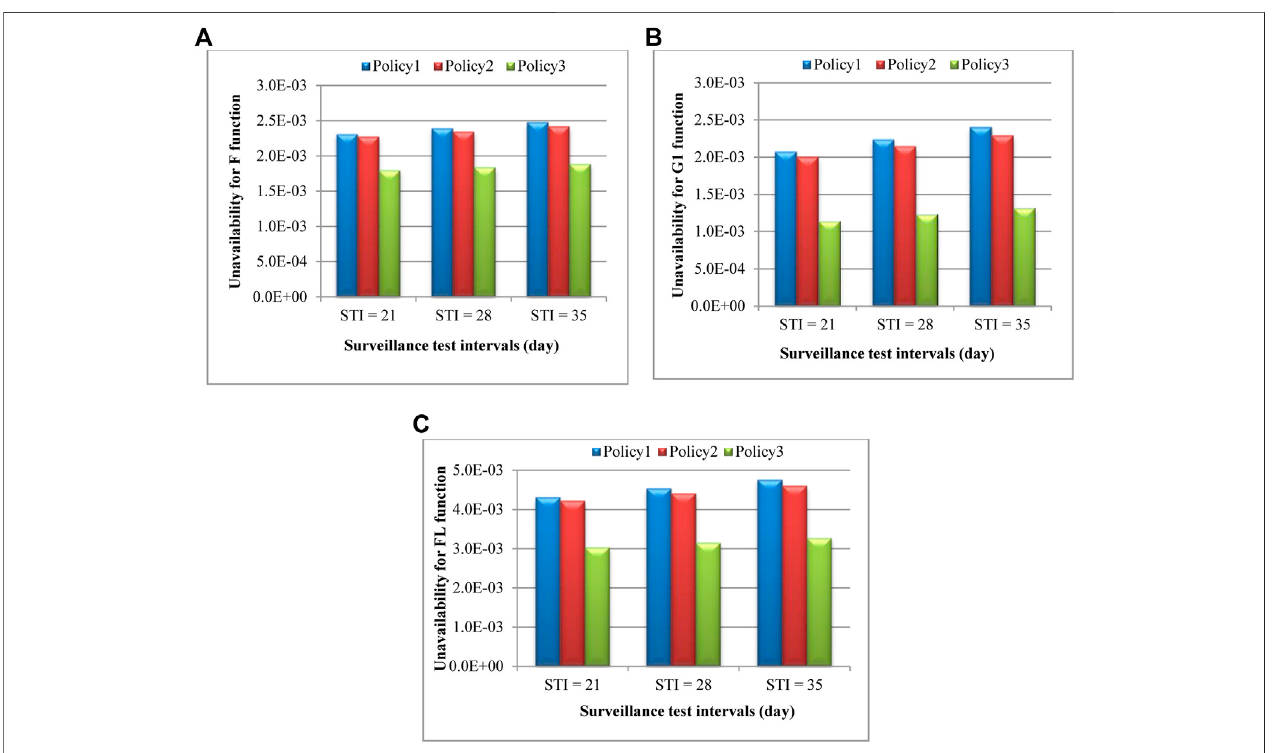
FIGURE 9 | Comparison of unavailability between different STIs and three maintenance policies for functions of ECCS: (A) F, (B) G1, (C) FL.